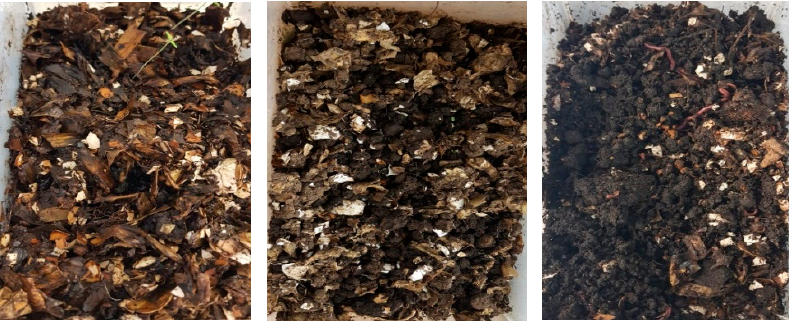
Figure 8. Tonalities observed in one of the mixes at the beginning, in the middle and at the end of the vermicomposting